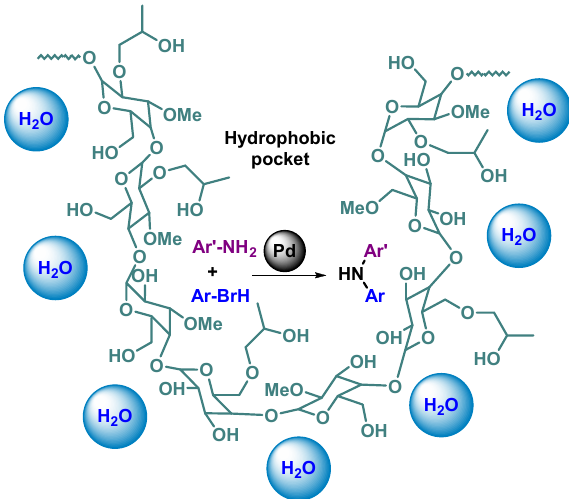
ered composite was found to efficiently catalyze heterogeneously C–H sulfenylation of